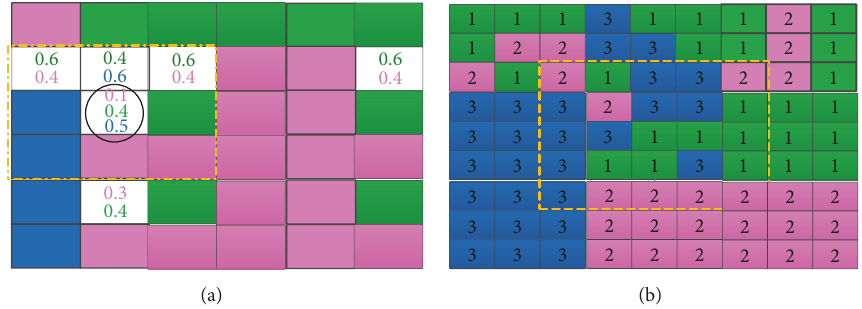
Figure 2: Pixel-by-pixel iterative optimization region: (a) original image; (b) spatial resolution enhancement